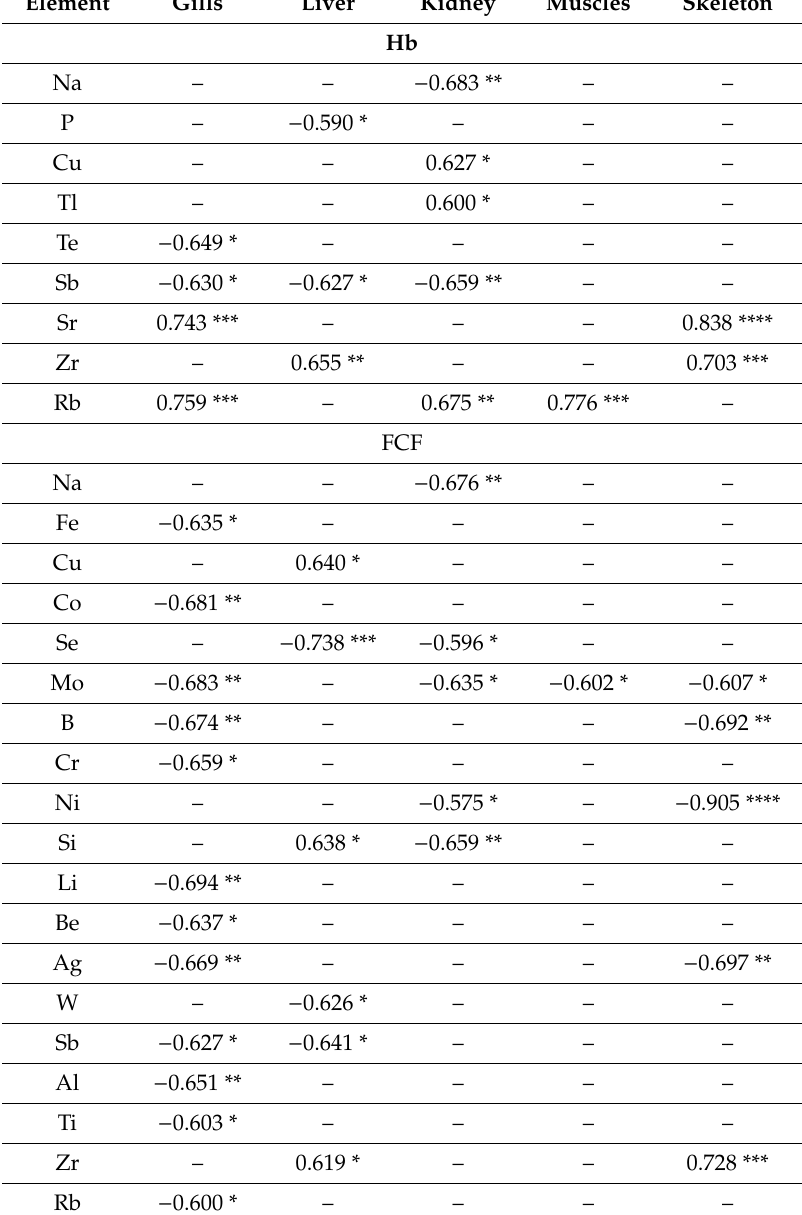
Table 3. Correlation coe ffi cients of the metal concentrations in the organs and tissues of whitefish, depending on the blood hemoglobin concentrations (Hb) and Fulton’s condition factor